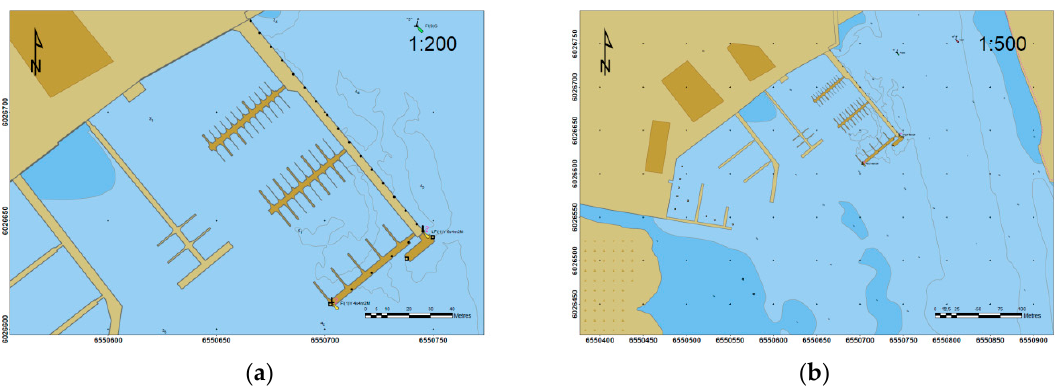
Figure 14. Navigational charts of the yacht port ( a ) and approach fairway ( b ) of the National Sailing Centre at the Gda ń sk University of Physical Education and Sport (NSC-GUPES), originating from the official Electronic Navigational Chart (ENC) cells.